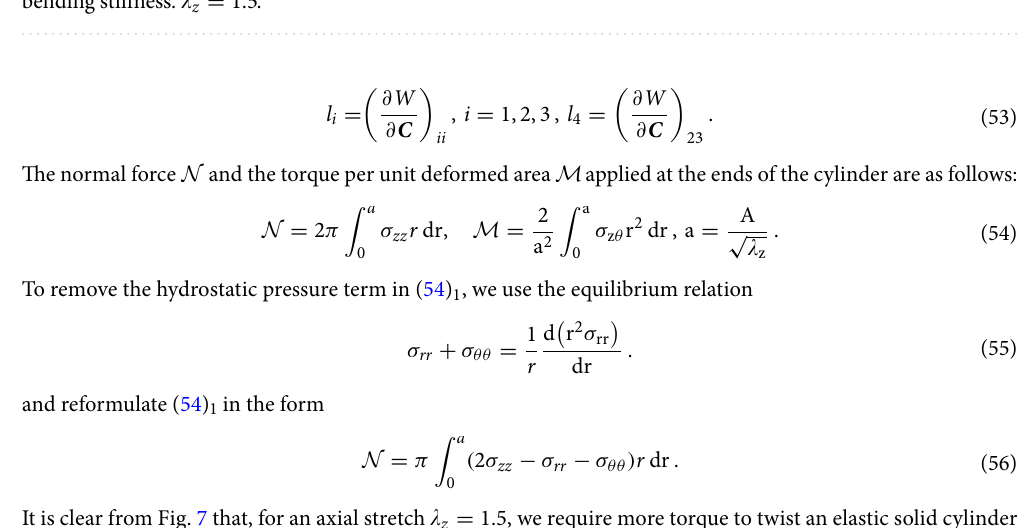
Figure 7. Torque, M versus τ . ( a ) Elastic solid with fibre bending stiffness. ( b ) Elastic solid with no fibre 1.5 bending stiffness. (cid:31) z =